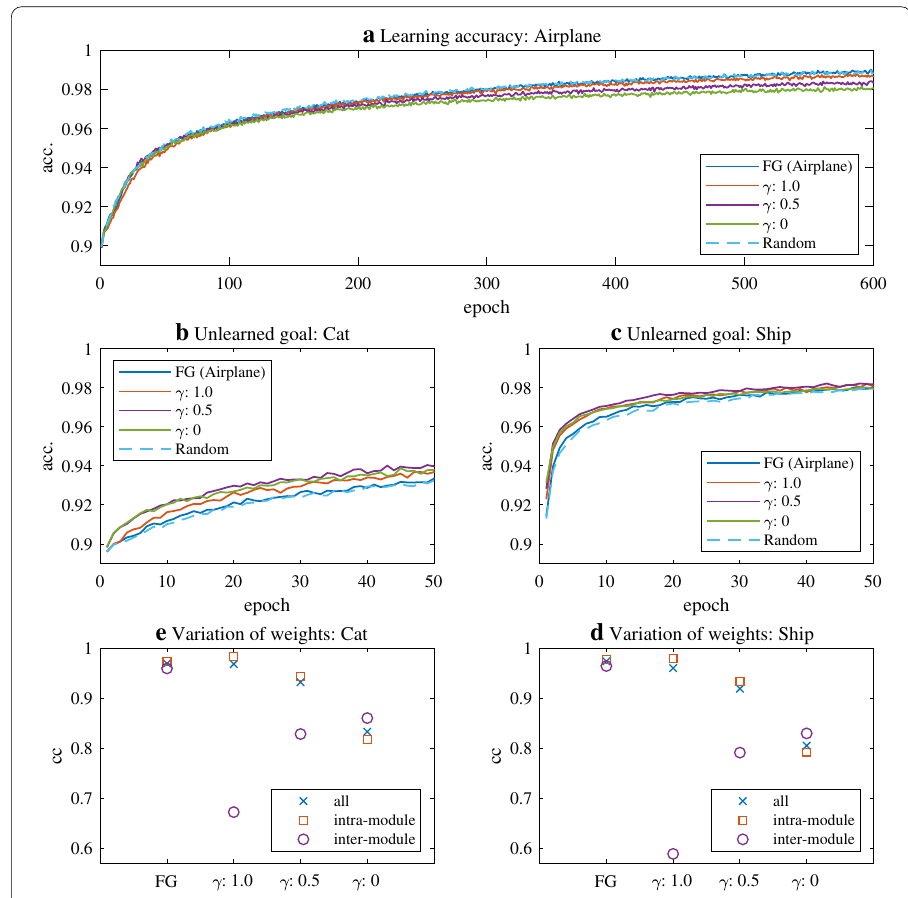
Fig. 5 Learning with the proposed approach. a Categorical accuracy against the goal. Blue indicates the FG of Airplane. The orange line indicates interMOD 1.0 . The purple line indicates interMOD 0.5 . The green line indicates interMOD 0 . b , c Categorical accuracy against the unlearned goals Cat and Ship. The weights of the initial neural network are from the last epoch of ( a ). e , d Pearson’s correlation coefficient (cc) against before and after learning the unlearned goals Cat and Ship. The cc values of the filter elements of the initial neural network and the last neural network in ( b , c ) are shown. Blue indicates the cc values of all the filter elements. Red indicates the cc values of elements in the filter corresponding to intra-module links. Purple indicates the cc values of elements in the filter corresponding to inter-module